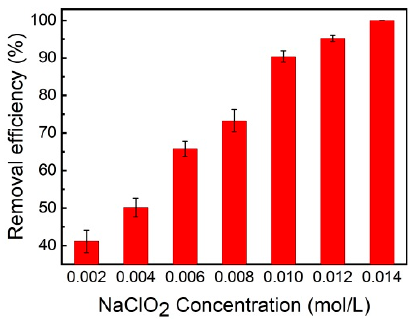
Figure 2. E ff ect of NaClO 2 concentration on NO removal e ffi ciency. Reaction conditions: initial pH 3; Figure 2. Effect of NaClO 2 concentration on NO removal efficiency. Reaction conditions: initial pH 3; temperature 30 ◦ C; NO inlet concentration 500 ppm; N 2 balance, with a total flow rate of 1.5 L / temperature 30 °C; NO inlet concentration 500 ppm; N 2 balance, with a total flow rate of 1.5 L/min.